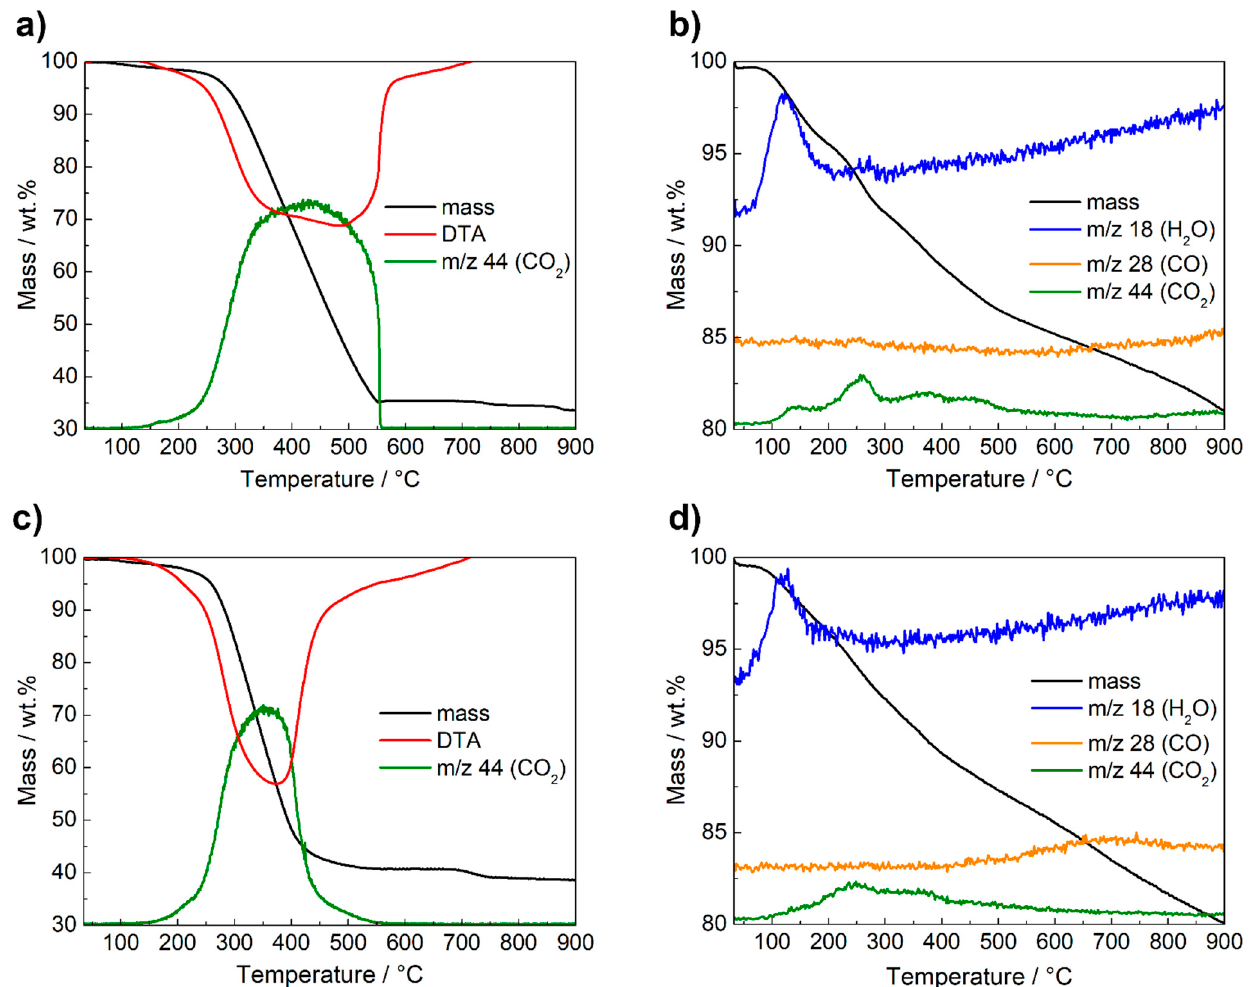
Figure 3. TGA-MS curves of Ag-Mn x O y /rGO ( a , b ) and Ag-Mn x O y /NGO ( c , d ) in O 2 /Ar (left) and Ar atmosphere (right). Ar atmosphere